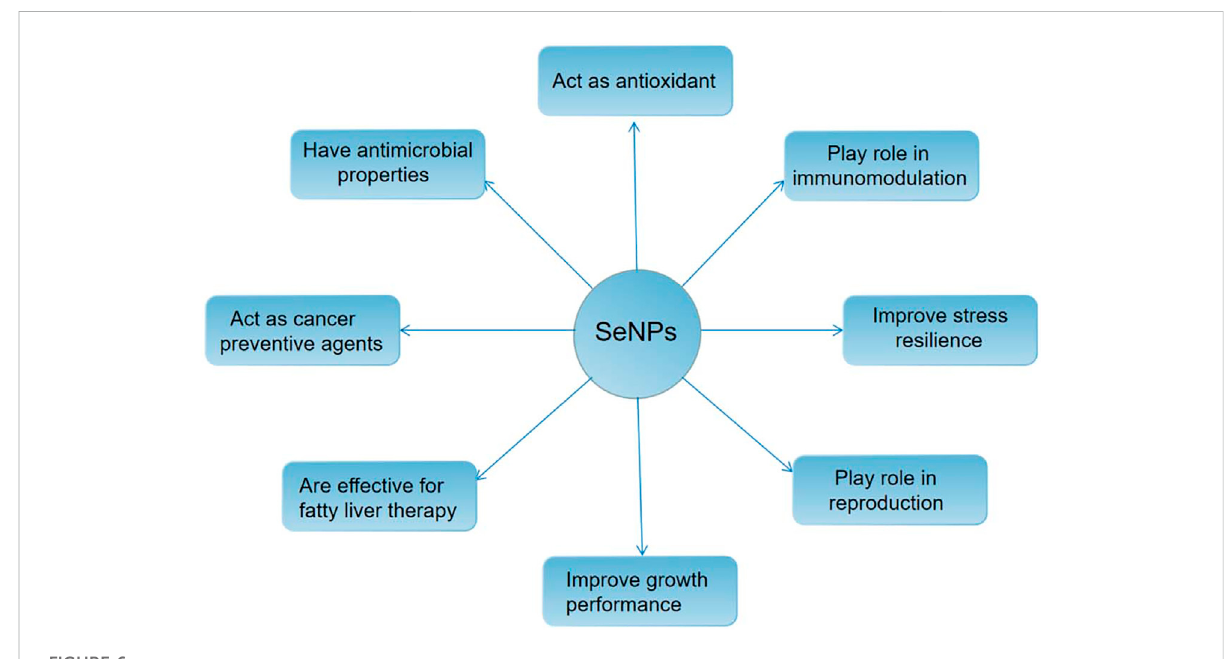
FIGURE 6 The application of nano selenium in medical fi